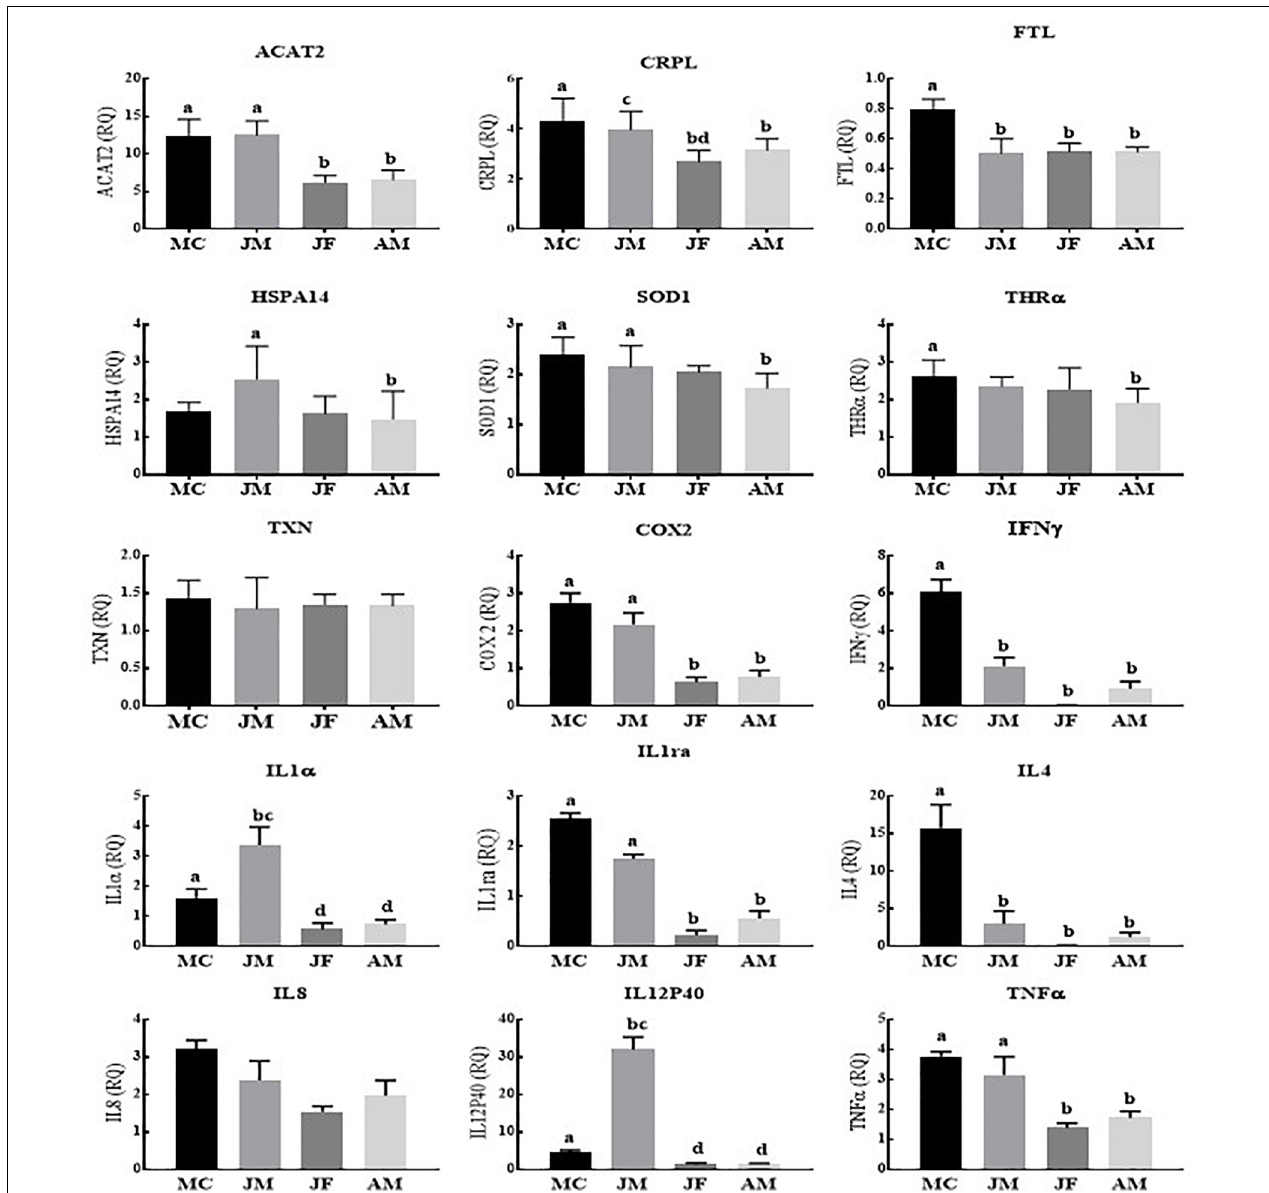
FIGURE 2 | Yangtze finless porpoises (YFPs) living in the Tian-E-Zhou Oxbow across the age groups. Each parameter followed by an alternate letter was significantly different at P ≤ 0.05. MC, Male calves; JM, Juvenile males; JF, Juvenile females; AM, Adult males.